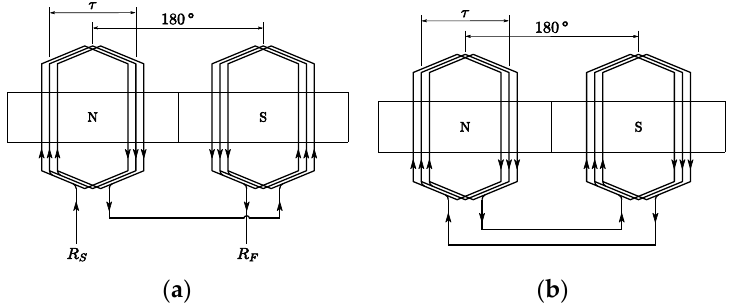
Figure 1. Unrolled view of a one-pole pair permanent magnet rotor with one phase ( a ) of a motor winding and ( b ) of an electrodynamic bearing winding if the rotor is internal.